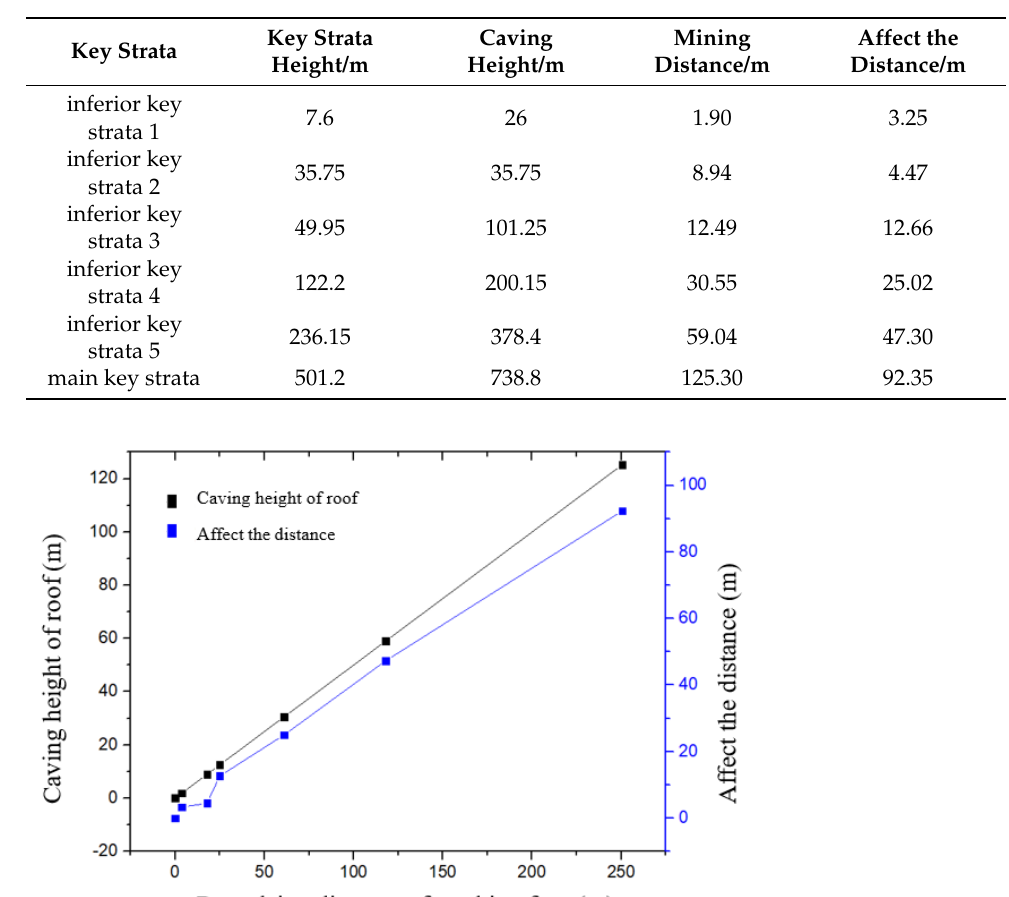
Table 2. Propelling distance and influence values.